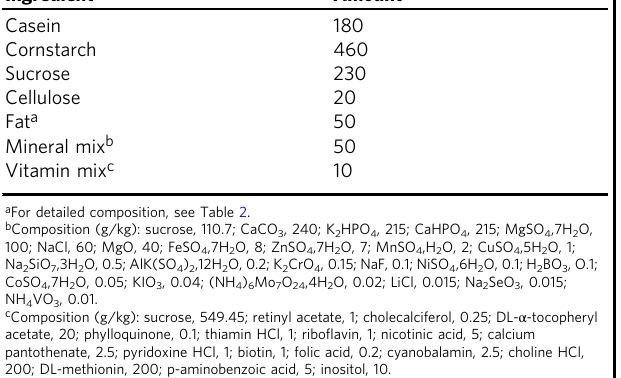
Fig. 2 Maternal n-3 PUFA de fi ciency increases microglial phagocytosis and gene expression pro fi le. a , b Representative images ( a ) and quanti fi cation ( b ) of EM data from the CA1 region of n-3 suf fi cient and n-3 de fi cient mice. s spine, m microglial processes, t terminals, * extracellular debris, ma myelinated axons. Arrowheads point to synaptic clefts. Scale bars = 1 μ m. Two-tailed unpaired Student ’ s t -test; t = 5.24, ** p = 0.0063, cleft; t = 3.366, * p = 0.0282, spine inclusions; t = 2.601, p = 0.06, cellular inclusions; t = 2.119, p = 0.1015, extracellular digestion. c Three-dimensional reconstructions of